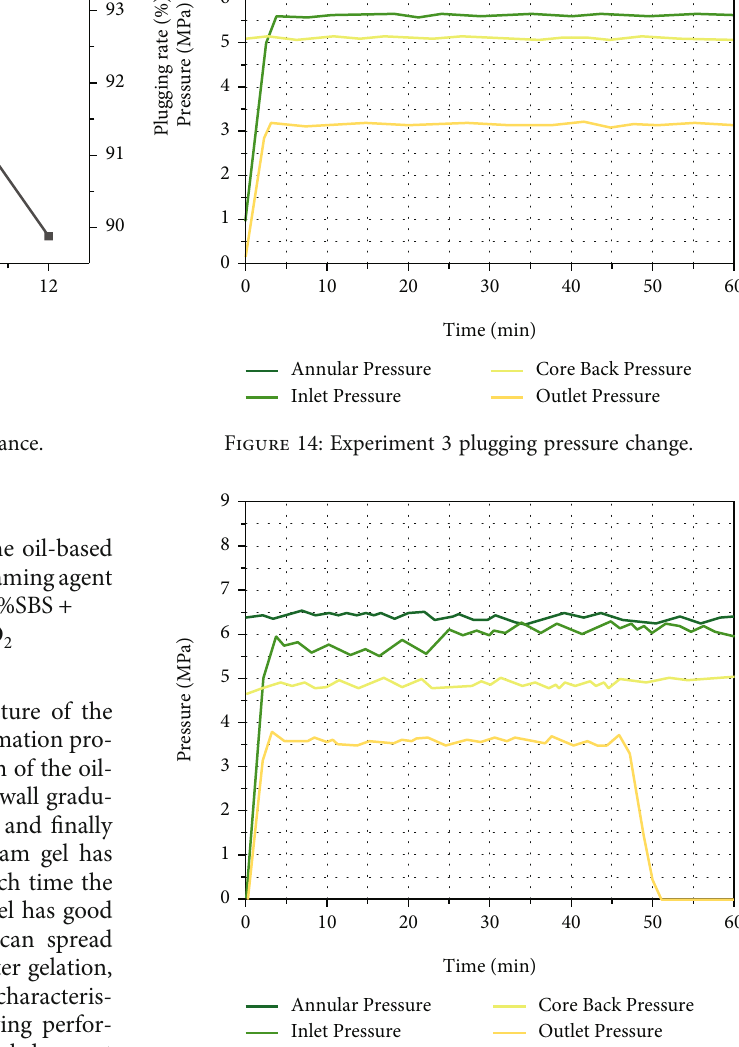
Figure 15: Experiment 4 plugging pressure